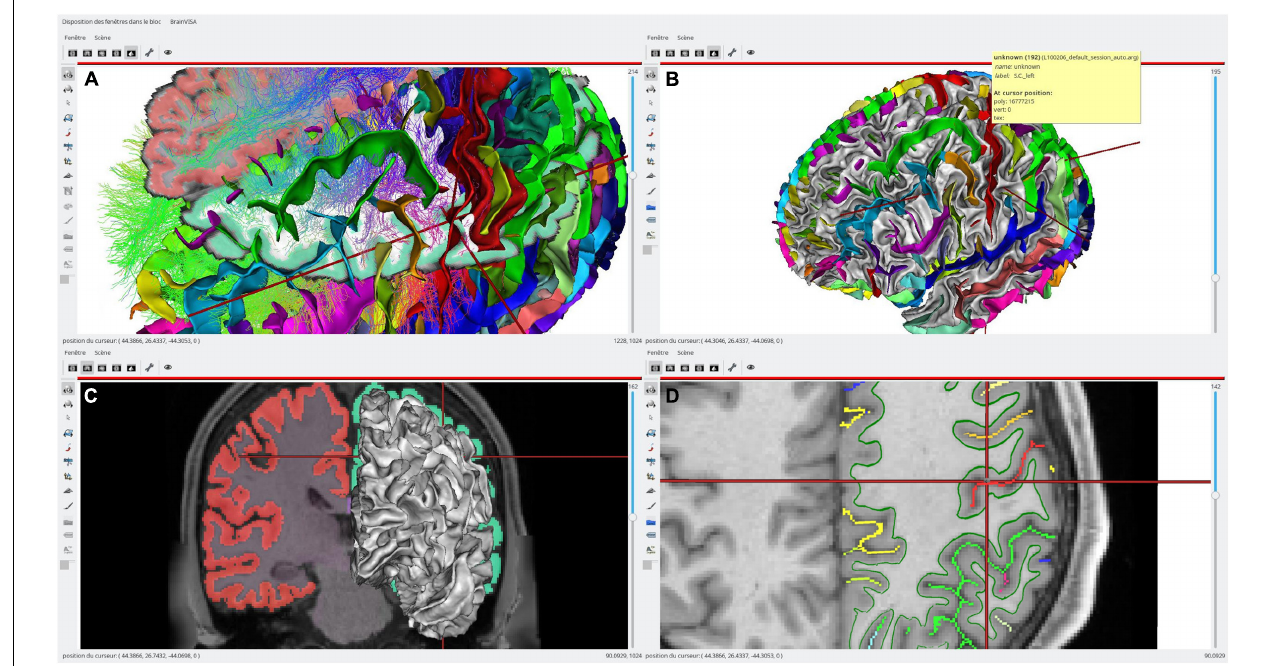
FIGURE 3 | An example of single subject, multimodal data visualization using Anatomist . On this example, we have displayed: ( A , top left) a skull-stripped T1 MRI slice and Freesurfer segmentation overlaid, a cortical sulci graph in 3D obtained using Morphologist, a subset of a tractography reconstructed by MRTrix, a clipped gray/white matters interface mesh with Desikan cortical regions obtained by Freesurfer; ( B , top right) the brain gray/white interface mesh and cortical sulci; ( C , bottom left) a skull-stripped T1 MRI slice and Freesurfer segmentation overlaid in coronal orientation and a left hemisphere gray/white mesh; ( D , bottom right) a skull-stripped MRI and a 2D representation of cortical sulci in axial orientation, with the gray/white mesh intersection on this plane (green). The objects live in different coordinate systems for acquisition and/or processing reasons (different kinds of software are processing using different spaces), and affine transformations between them have been loaded in Anatomist . Object’s location and cursor position match in all